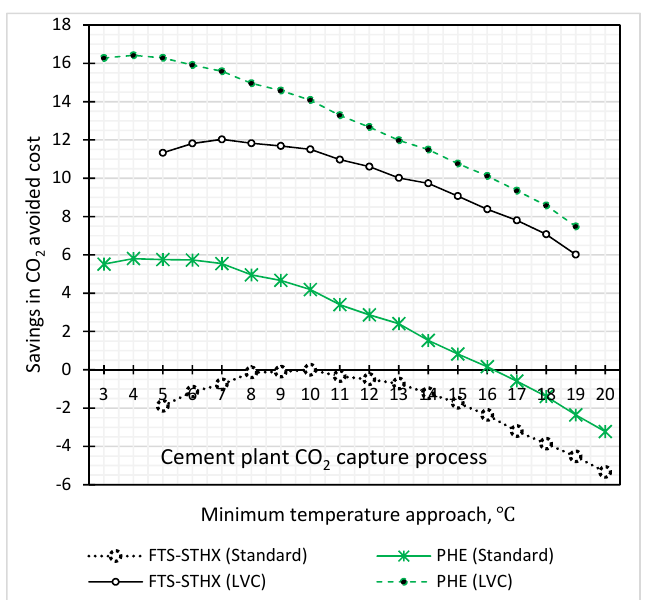
Figure 15. Cost reduction analysis at different ∆ T min for different heat exchanger types compared with FTS–STHX of ∆ T min = 10 ◦